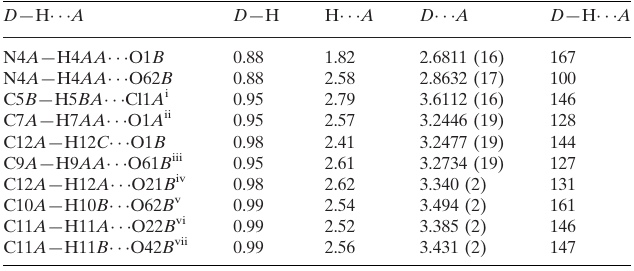
Hydrogen-bond geometry (A˚ , (cid:4) ). D —H (cid:2)(cid:2)(cid:2)